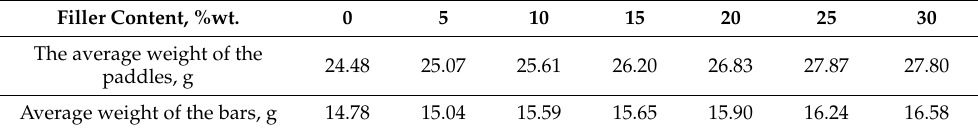
Table 5. Changes in the mass of samples depending on the content of the Crusil M20 filler. Filler Content, %wt.